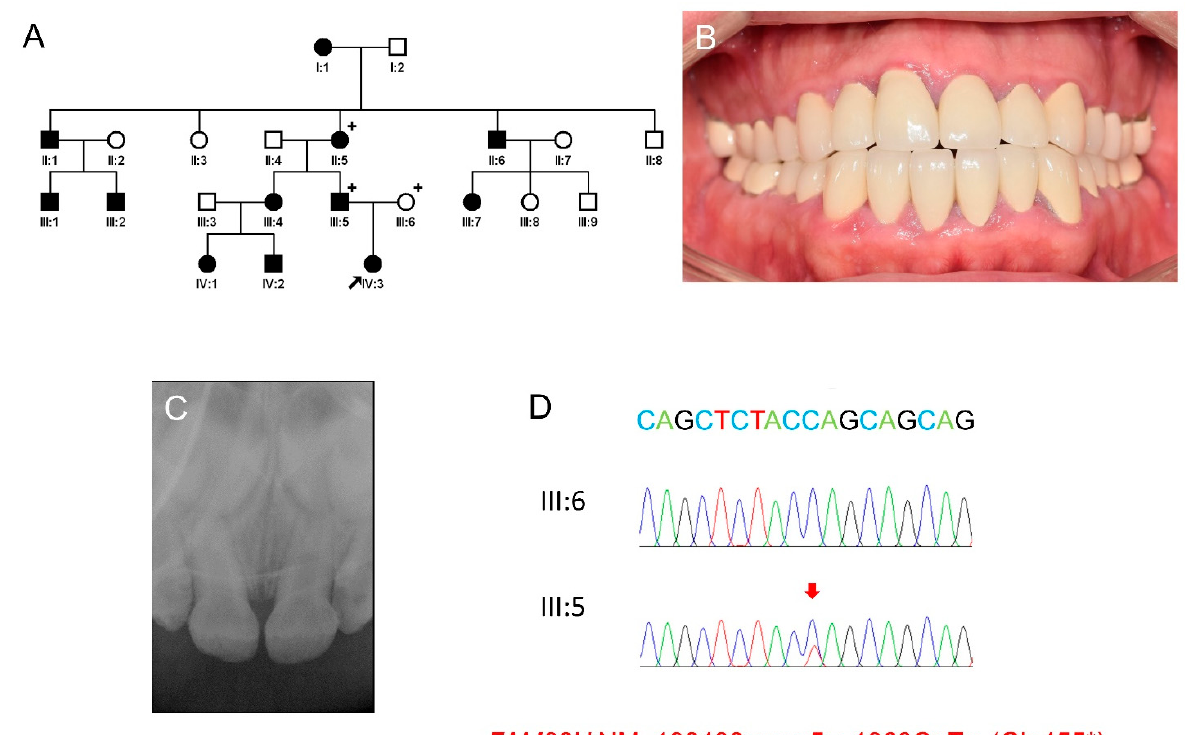
Figure 1. Pedigree, clinical photo of the father, periapical radiograph of the maxillary anterior teeth of the proband, and sequencing chromatograms. ( A ) The pedigree of the family indicates an autosomal dominant inheritance pattern. The plus symbols indicate the participating members for the genetic analysis. A black arrow indicates the proband. ( B ) Clinical photo of the father (III:5) shows a full-mouth restoration. ( C ) A periapical radiograph of the maxillary anterior teeth of the proband at age 2 years 9 months. ( D ) Sequencing chromatograms of the mother (III:6) and the father (III:5). Nucleotide sequence is shown above the chromatogram and the mutated nucleotide is indicated by a red arrow.